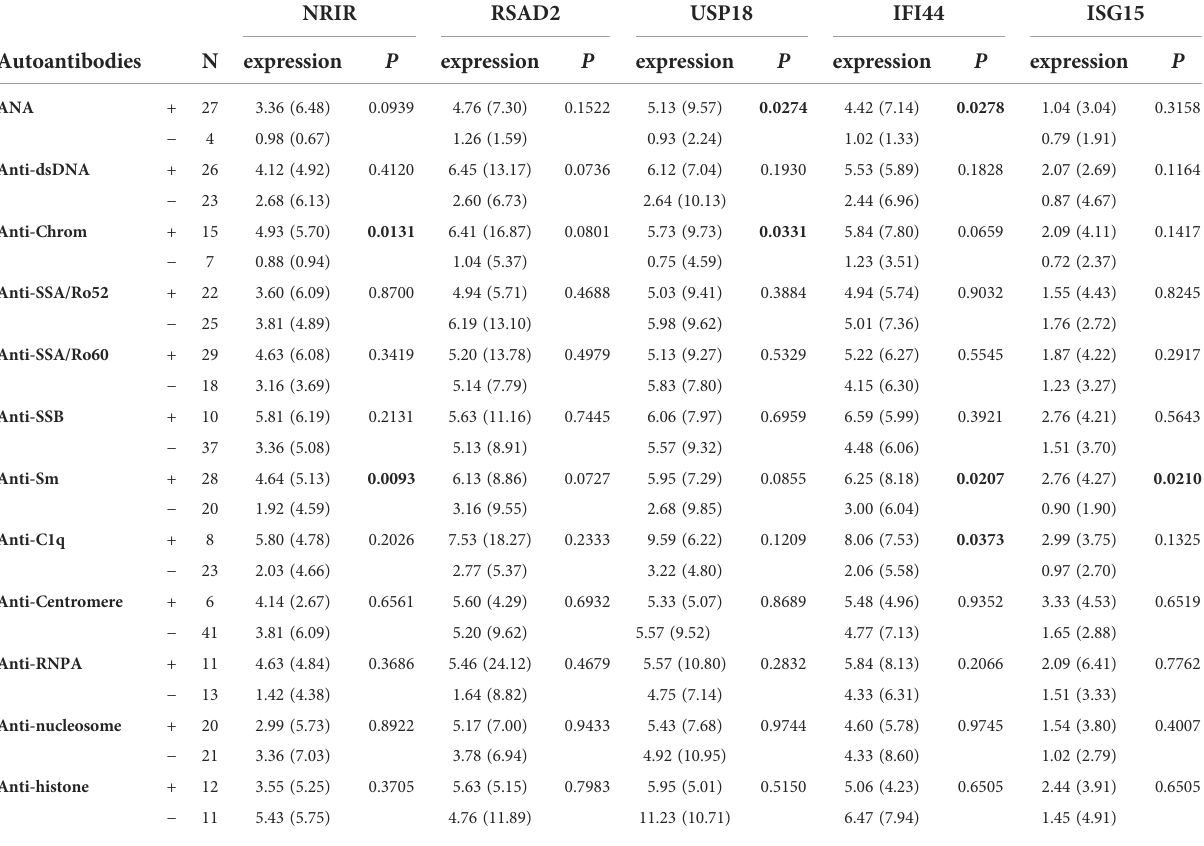
TABLE 5 The relationships of relative expressions of ISGs in PBMCs with the autoantibodies of SLE patients. NRIR RSAD2 USP18